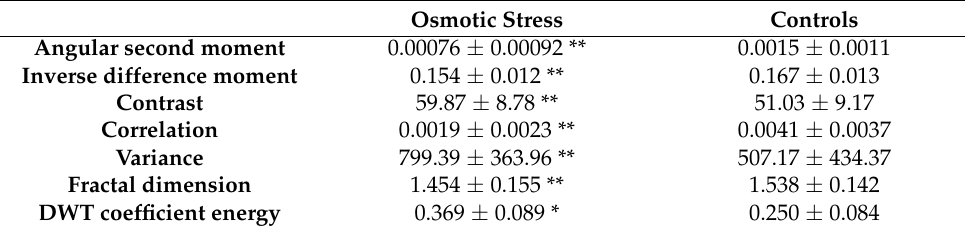
Table 1. Average values of GLCM, fractal and DWT indicators of nuclear ROIs on cells exposed to hyperosmotic environment and controls. * p < 0.05 ** p < 0.01.